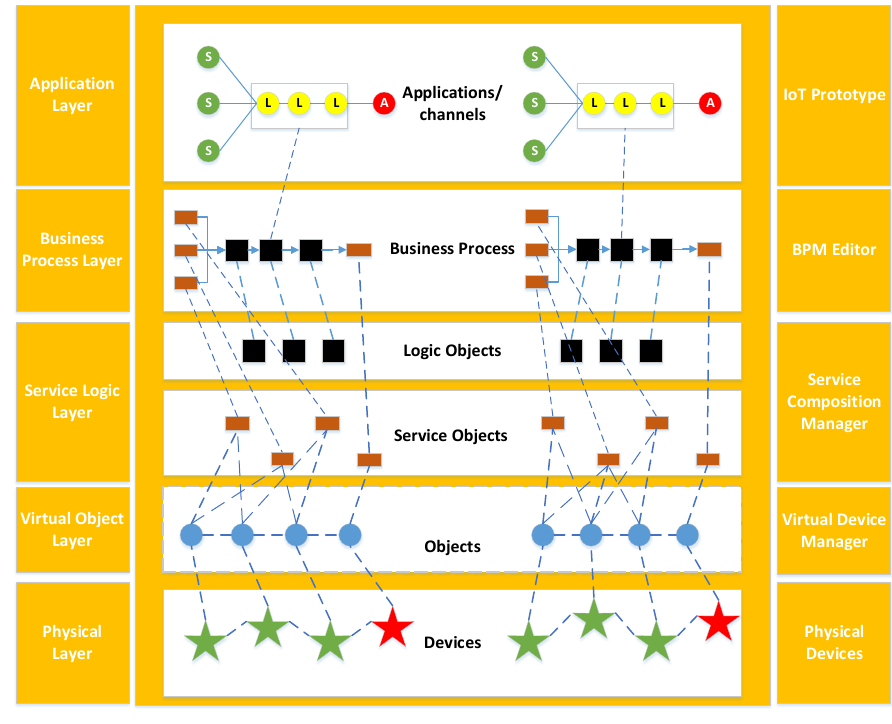
Figure 3. DIY toolbox layered